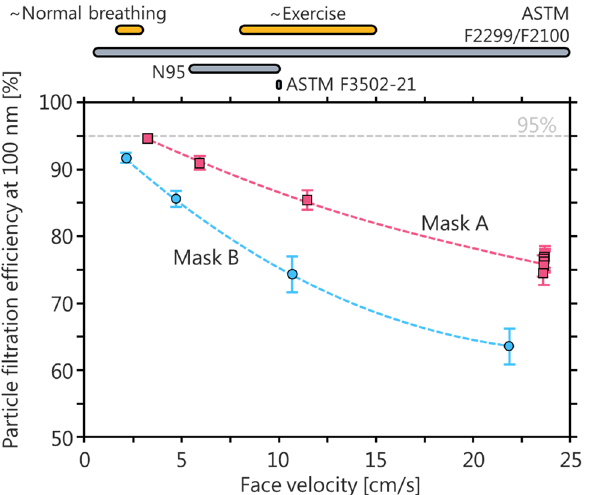
Figure 5. The impact of face velocity on the PFE measured for two medical face masks under the ASTM F2299 test method. The upper grey bars illustrate face velocities (ratio of flow rate to surface area) for the ASTM F2299, ASTM F3502-21, and NIOSH test methods (the range of values indicated for the NIOSH method correspond to the range of N95 surface areas discussed in the text). The upper yellow bars illustrate upper-limit face velocities for normal breathing and exercising flow rates through N95 respirators. The increase in PFE with decreasing face velocity for these 100 nm PSL particles was predicted in Fig.